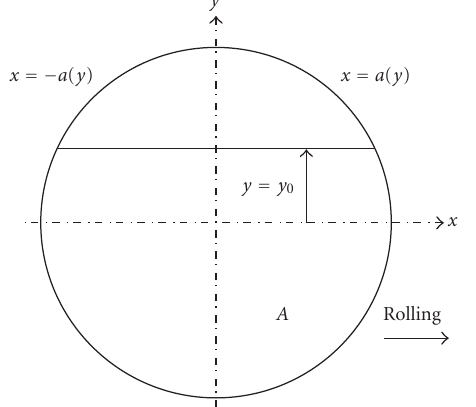
Figure 6: The case of rolling without slip (left) and rolling with slip